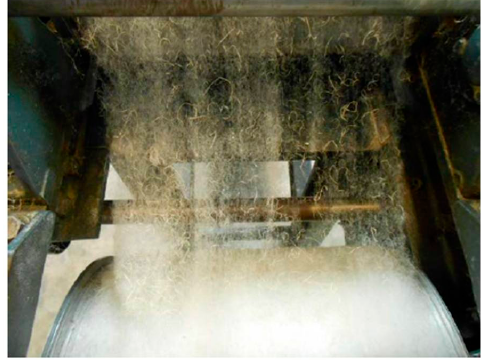
Figure 6. Veil cohesion for 50/50 blend of banana and cotton fibers.